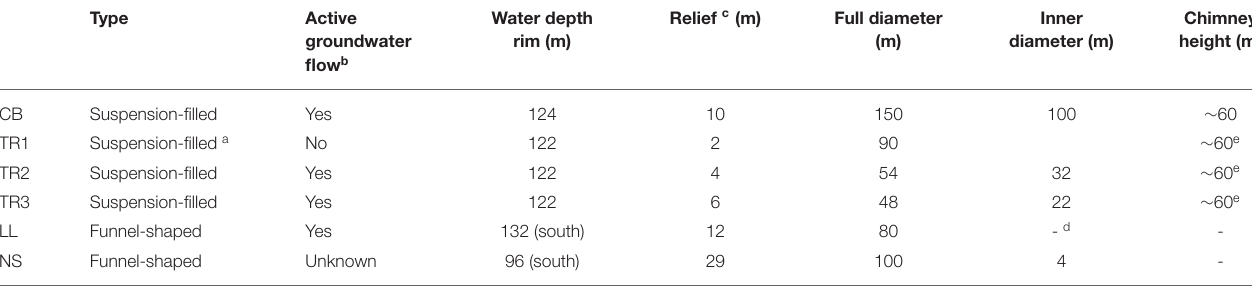
a Consolidated. b Based on the results from this study.